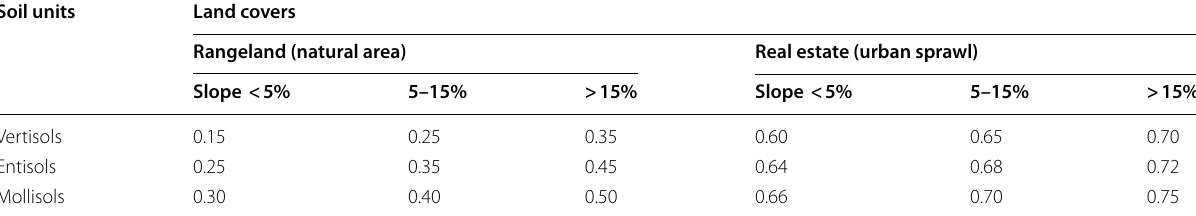
Table 1 Determination of the runoff coefficients (Cr) in the watersheds of the study area based on the land covers, soil units and slope ranges (after Mousavi et al. 2019) Soil